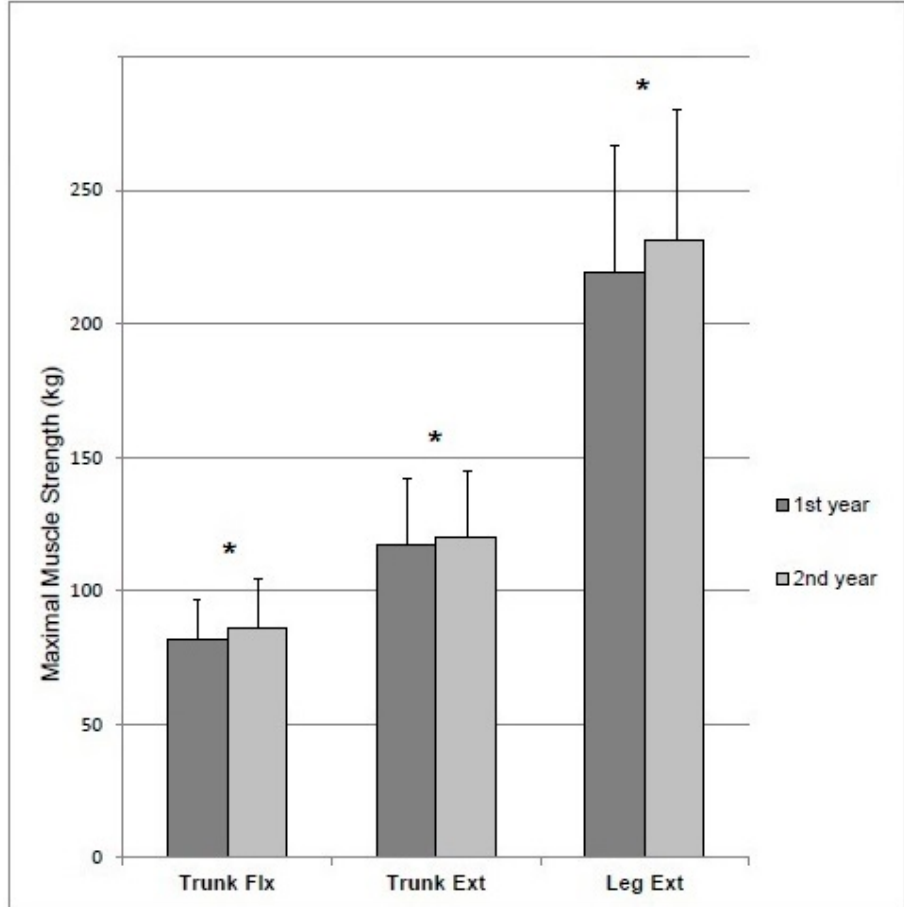
Figure 1. Mean (SD) maximal muscle strength of the trunk flexor, trunk extensor and leg extensor muscles during the first and second academic year. * p < 0.05.